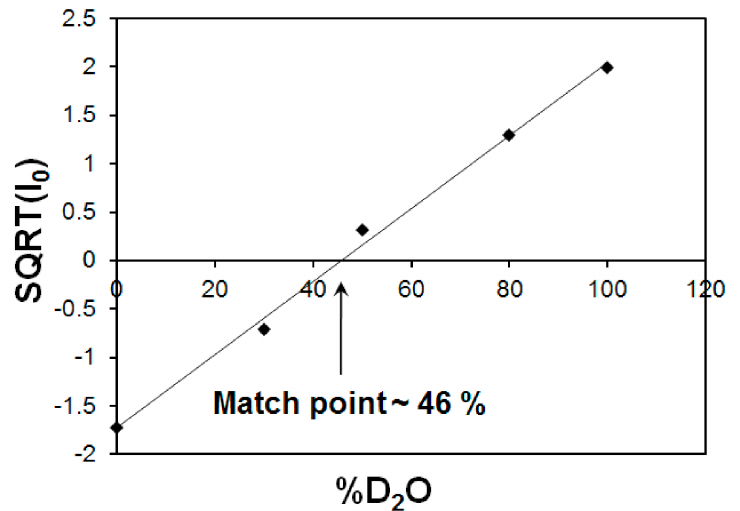
Figure 7. Square root of the scattering intensities at zero angle (I o0 ) as a function of D 2 O volume fraction. The intersection of the fitted straight line with x-axis corresponds to match point of 46% for MFer with LF